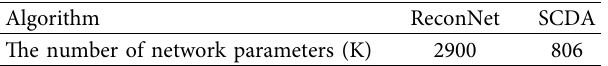
Table 6: The average time required for the reconstruction process (the measurement rate is